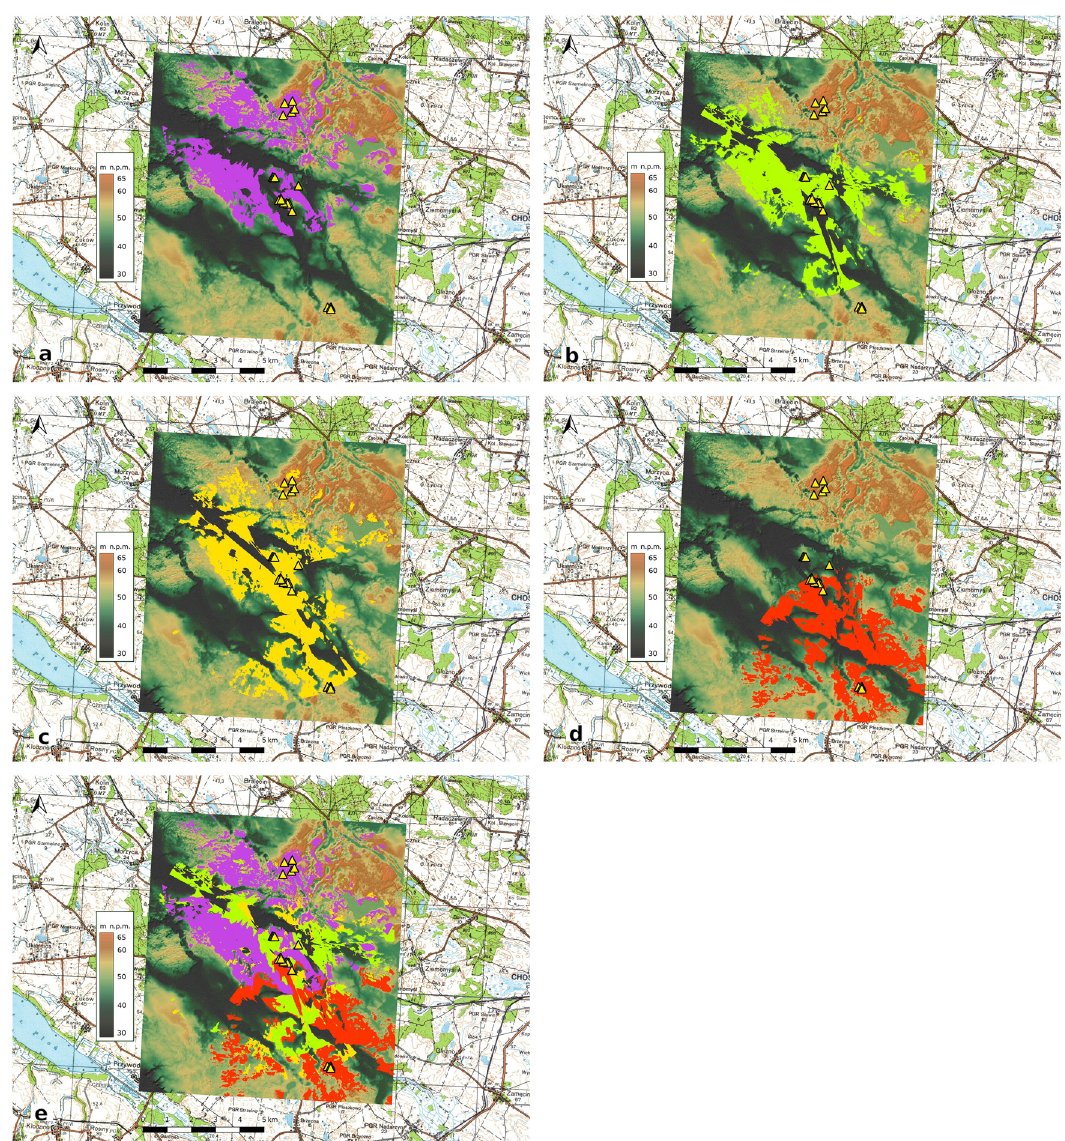
Figure 23: Megalithic groups of Dolice - Rondo Lucjana ( a ) , Dolice - Komorowo North ( b ) , Dolice - Komorowo South ( c ) and P ł oszkowo ( d ) visible from other megalithic tombs in the Dolice region and the juxtaposed intervisibility views between these groups ( e ) ( M. Schiller )